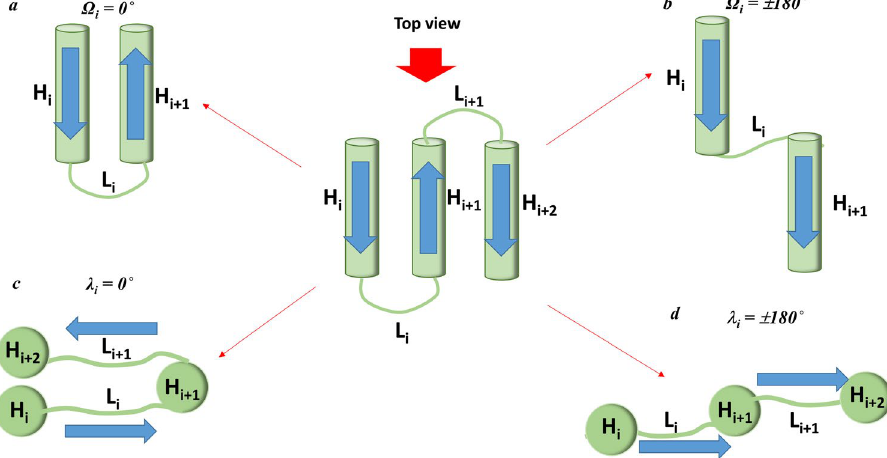
Figure 3. Arrangements of the helices and loops depending on the Ω and λ dihedral angles. The central figure presents the front view of three consecutive helices in the membrane proteins. H (n) represents the helices and L (n) represents loops. ( a ) Front view of the arrangement of two adjacent helices, H i and H i + 1 when Ω i = 0°, ( b ) Front view of the arrangement of two adjacent helices, H i and H i + 1 when Ω i = ± 180°, ( c ) Top view of the arrangement of two adjacent loops, L i and L i + 1 , and three adjacent helices, H i , H i + 1 and H i + 1 , when λ i = 0°, and ( d ) Top view of the arrangement of two adjacent loops, L i and L i + 1 , and three adjacent helices, H i , H i + 1 and H i + 1 , when λ i = ± 180°. These figures show the possible scenario depending on the dihedral angles rather than a real arrangement observed in TM proteins.